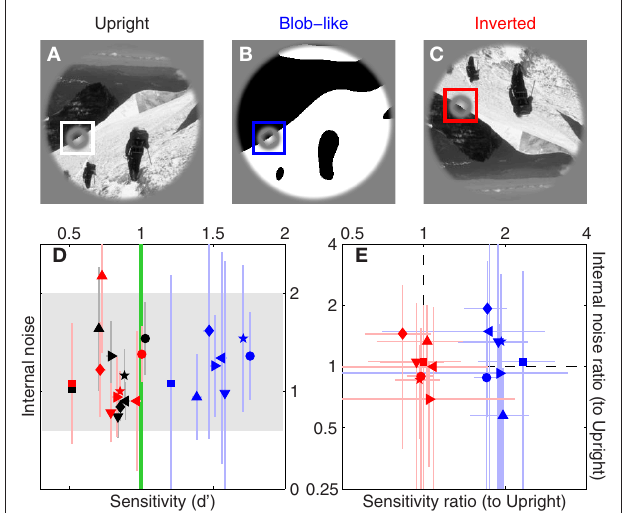
Figure 3 | Sensitivity and internal noise for upright natural (A), blob-like (B) and inverted images (C); color-coding is black, blue and red respectively. (D) Plots d ′ on the x axis versus internal noise on the y axis (see Section 2.4 for details on how the latter was estimated). Gray shading shows internal noise range expected from previous studies (Neri, 2010a); green vertical line shows the desired d ′ target value of 1 (Murray et al., 2002). (e) Plots ratios between d ′ for blob-like and d ′ for upright natural images (blue) on the x axis, versus ratios between internal noise for blob-like and internal noise for natural images on the y axis. Red symbols plot the same but for inverted instead of blob-like images. Dashed lines indicate unity ratios. Each symbol refers to a different observer. Error bars show ± 1 SEM.